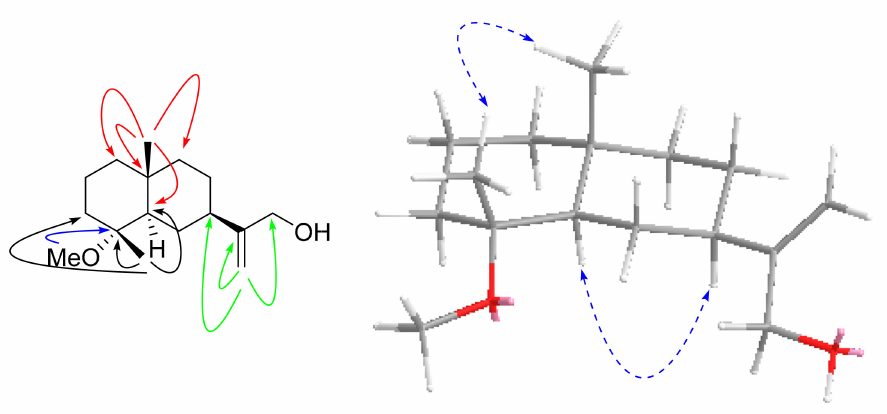
Figure 7. Key HMBC ( → ) and ROESY ( ↔ ) correlations for Compound 3